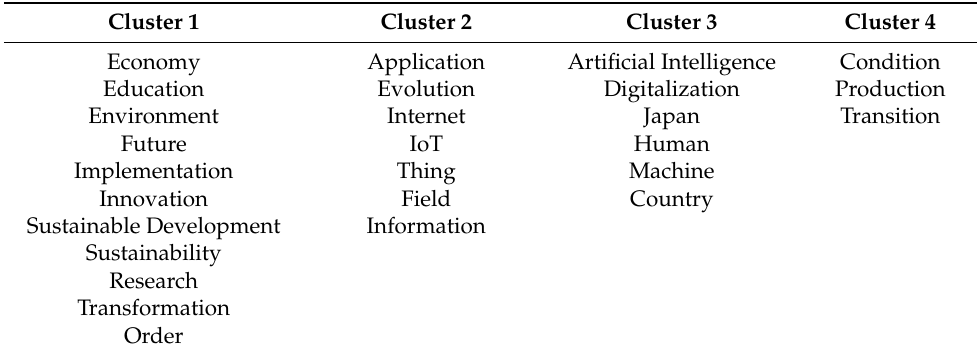
Table 1. Clusters as constructed by VOSviewer Software. Cluster